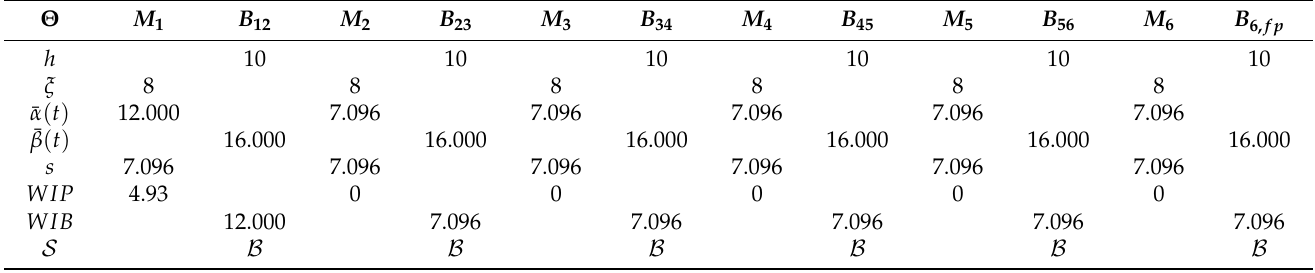
Table 5. Average values for the non-homogeneous birth–death process for 100 h of